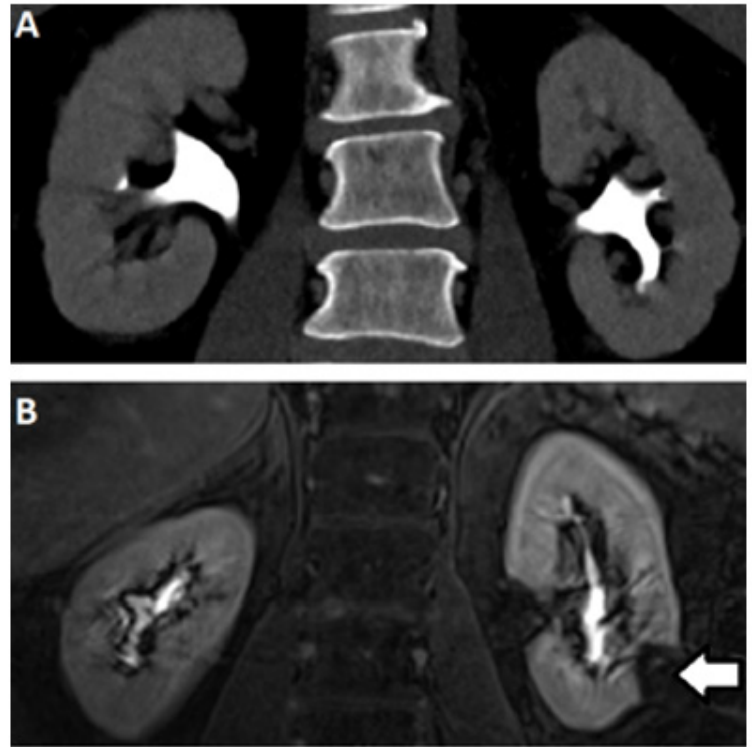
Figure 4. Excretory phase CT ( A ) and MRI ( B ) demonstrating normal caliber renal collecting systems without filling defect. Note the absence of signal in the left lower pole (arrow) corresponding to a renal cyst.